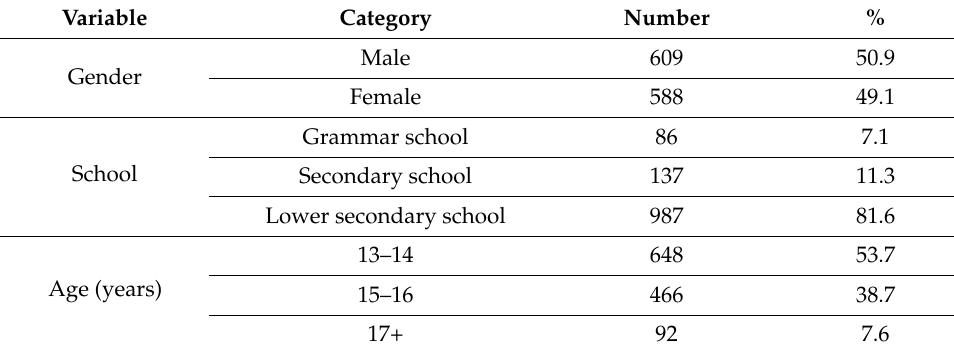
Table 1. Description of the sample ( n =